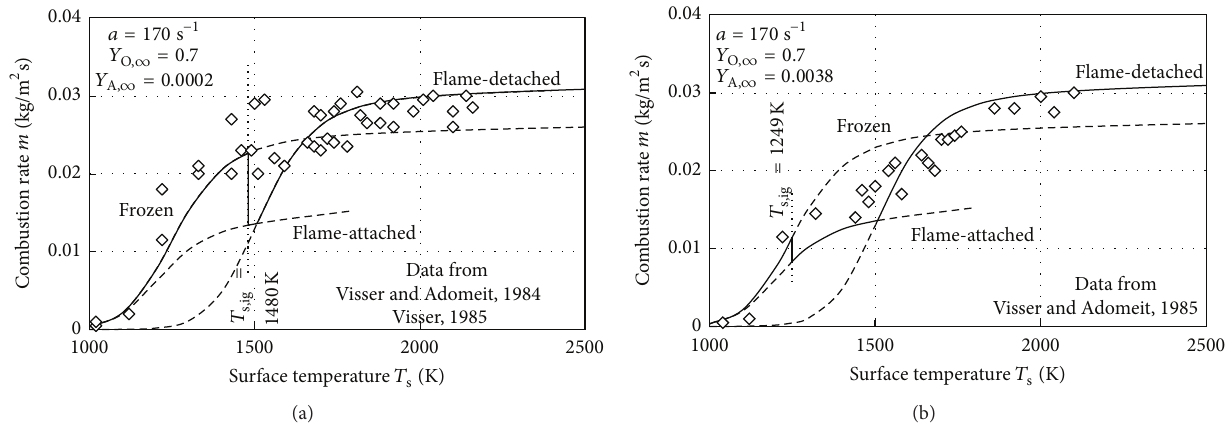
Figure 1: Combustion rate of the graphite hemisphere in oxidizer flow with the velocity gradient of 170s −1 , as a function of the surface temperature: (a) for the O 2 mass-fraction 𝑌 points are experimental [34, 41] and curves are calculated from the theory in [23]. The ignition surface-temperature 𝑇 on the ignition analysis [32].